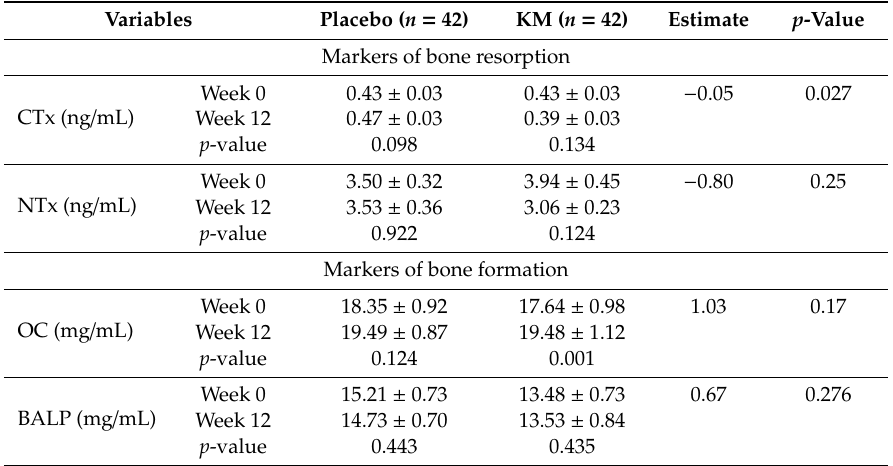
Table 3. Changes in bone turnover markers in the blood.